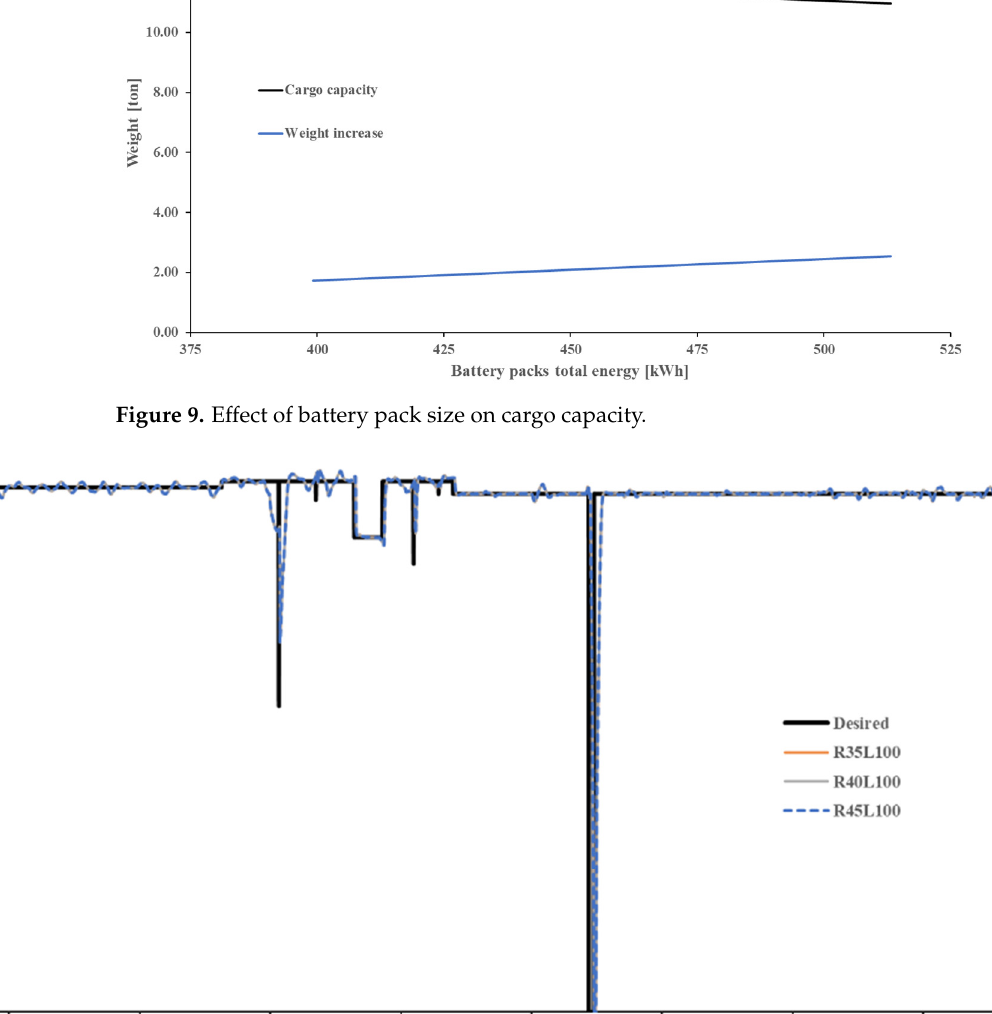
Figure 9. Effect of battery pack size on cargo capacity.